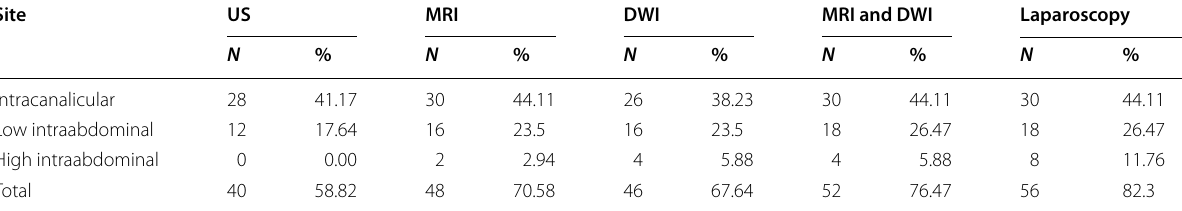
Table 3 Comparison of conventional MRI, DWI, laparoscopy and US results according to site Site